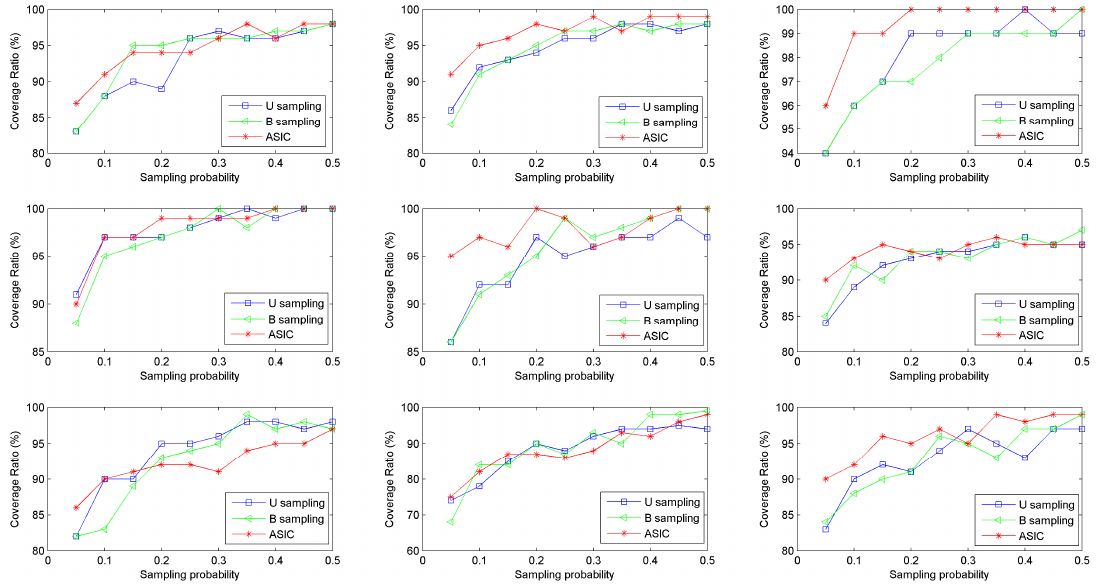
Figure 4. Coverage of sampled data.